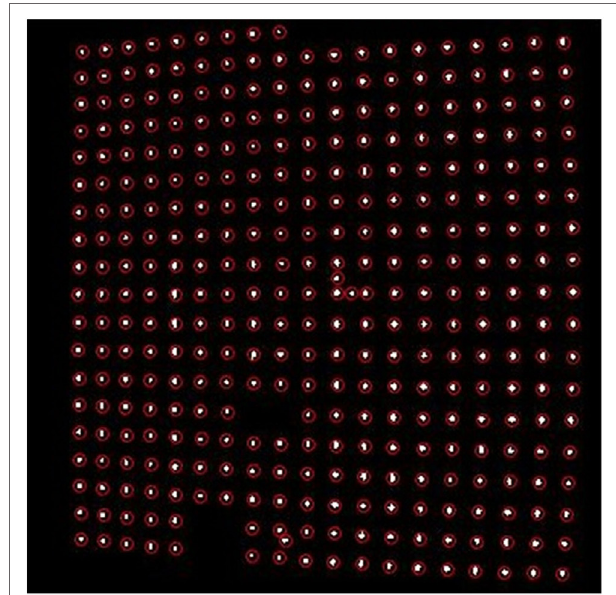
FIgURe 2 | White markers are a binary representation of an infrared image of a calibration pattern. Red circles are drawn around the exact centroid locations of detected